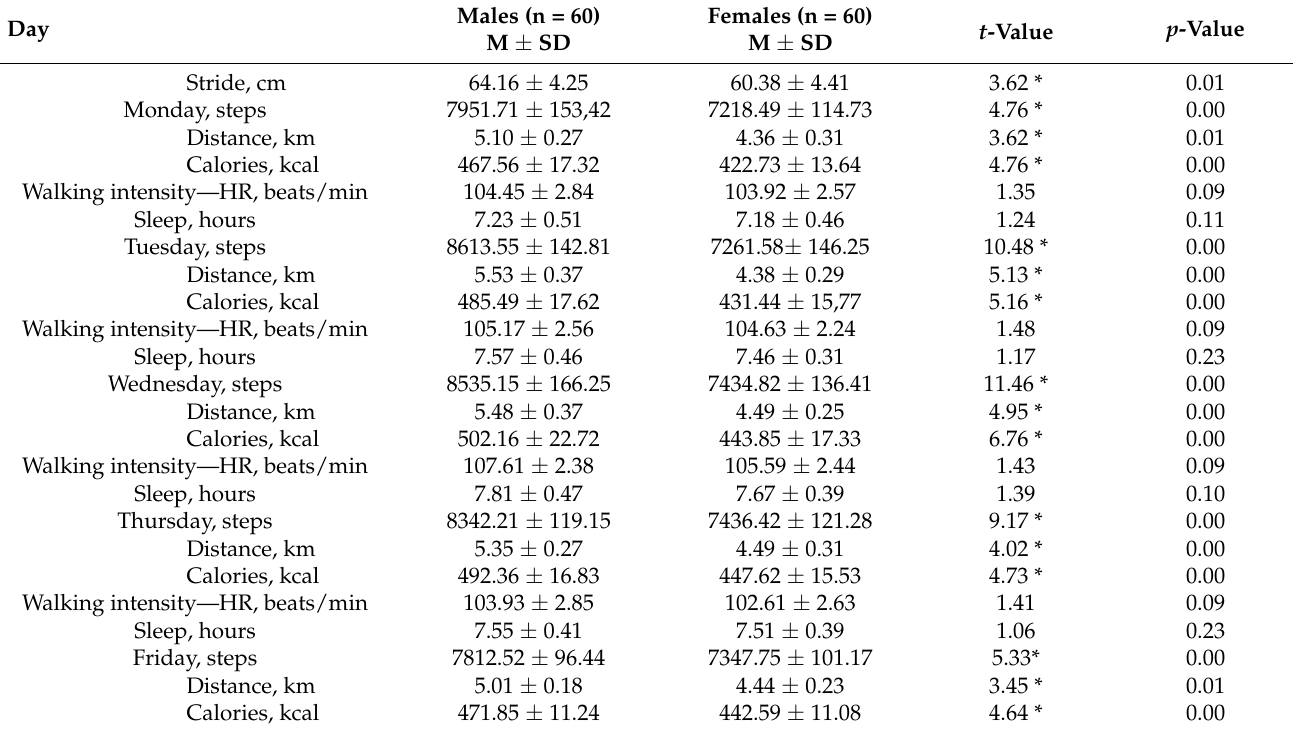
Table 4. Descriptive statistics, t -test of average stride, steps, distance walked, and calorie intake for males and